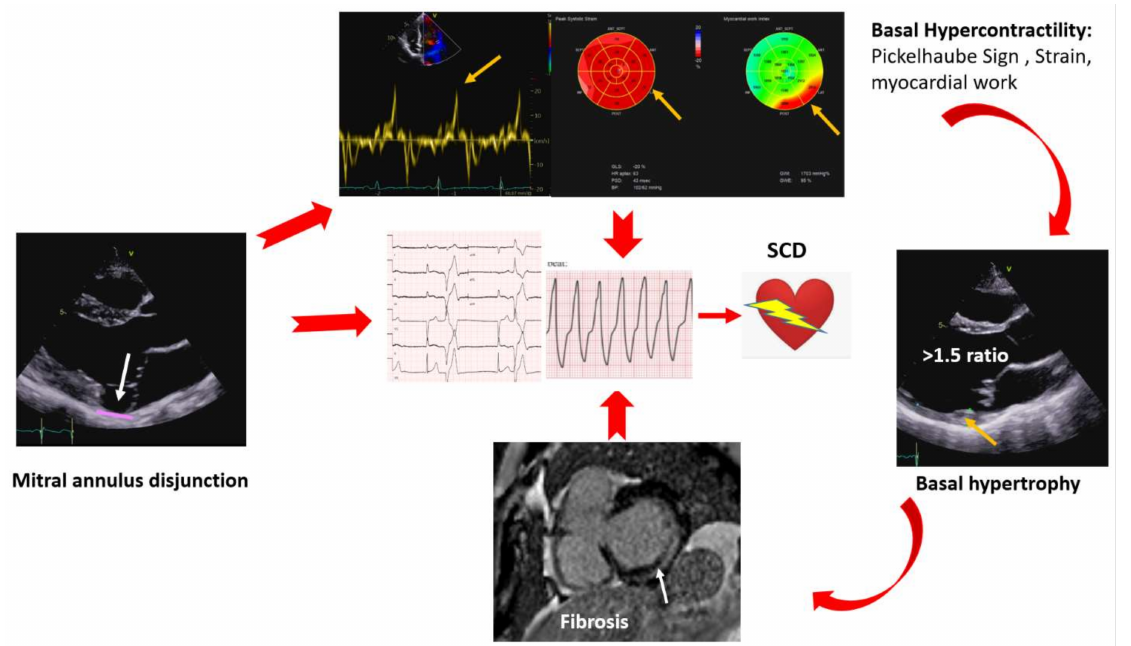
Figure 3. Mitral annulus disjunction, hypercontractility, increased myocardial work, basal hypertro- phy, and myocardial fibrosis; all may lead to complex arrhythmias and eventually sudden cardiac death